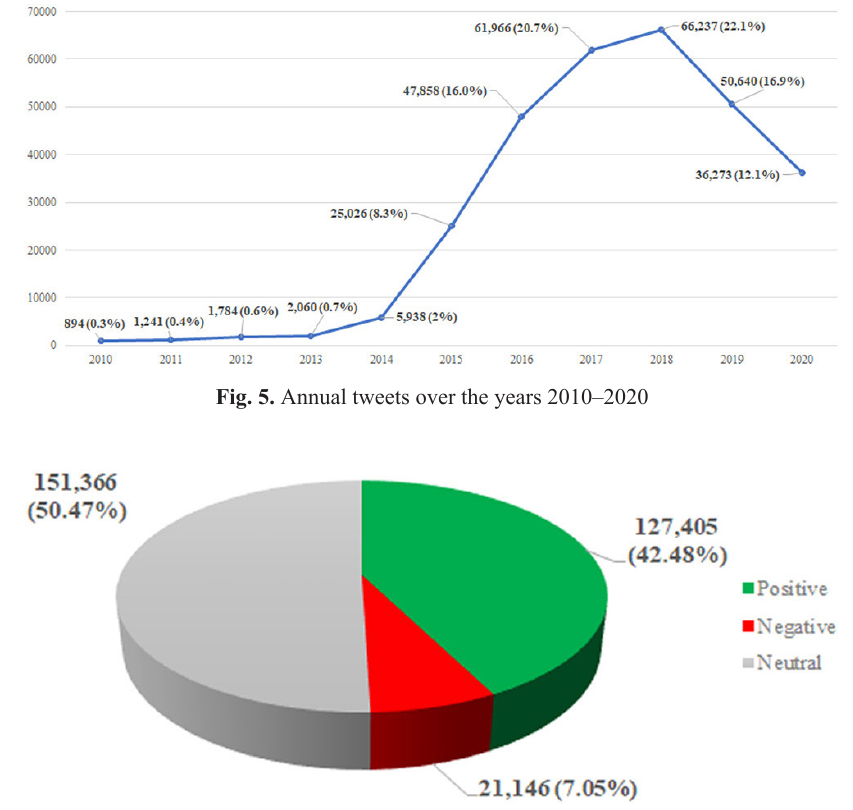
Fig. 6. Polarity frequency of the educational tweets over the years 2010–2020 using TextBlob